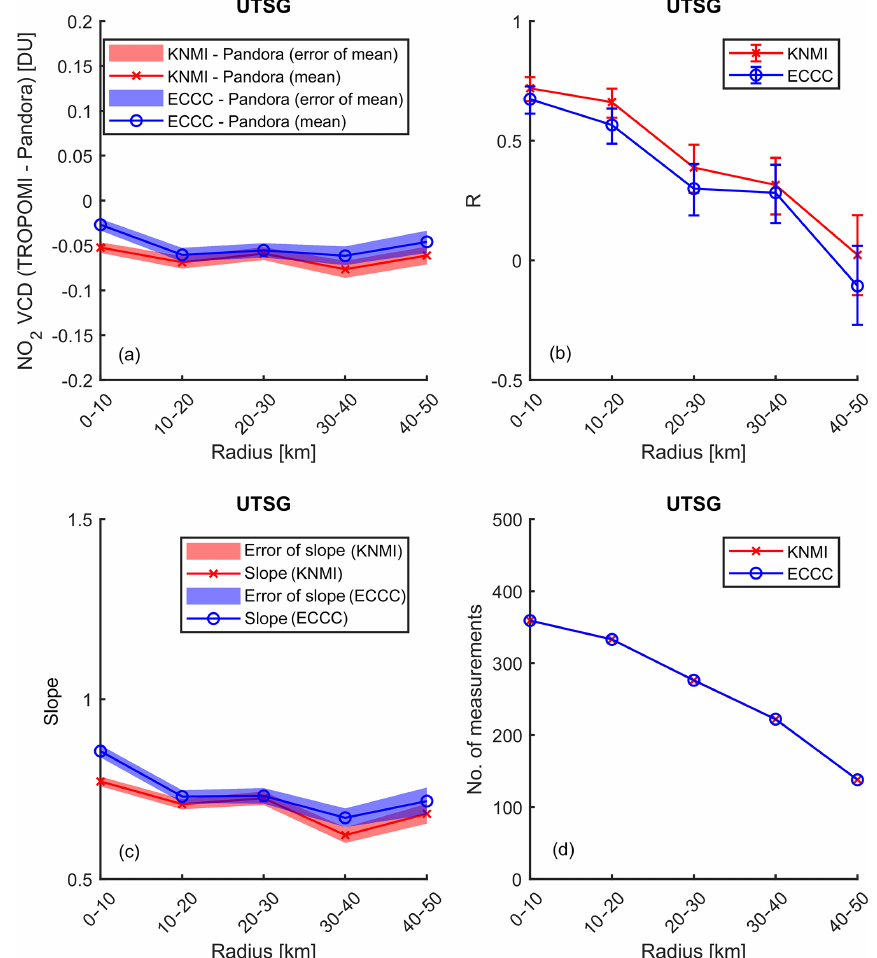
Figure B2. Sensitivity test for Pandora no. 145 at UTSG. Descriptions of the legend in Fig. B1.